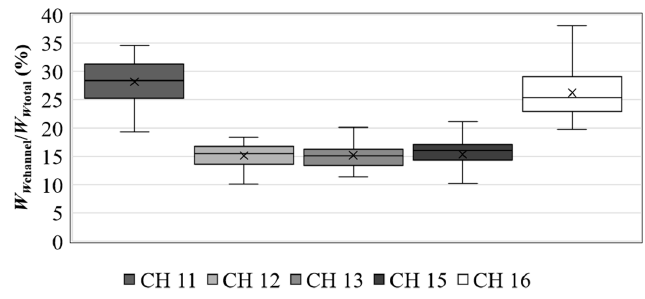
Figure 15. Overtopping volume distribution over the five dam crest sections (see Figure 6). The width of each channel is one fifth of the total dam crest length l c . of each channel is one fifth of the total dam crest length l c